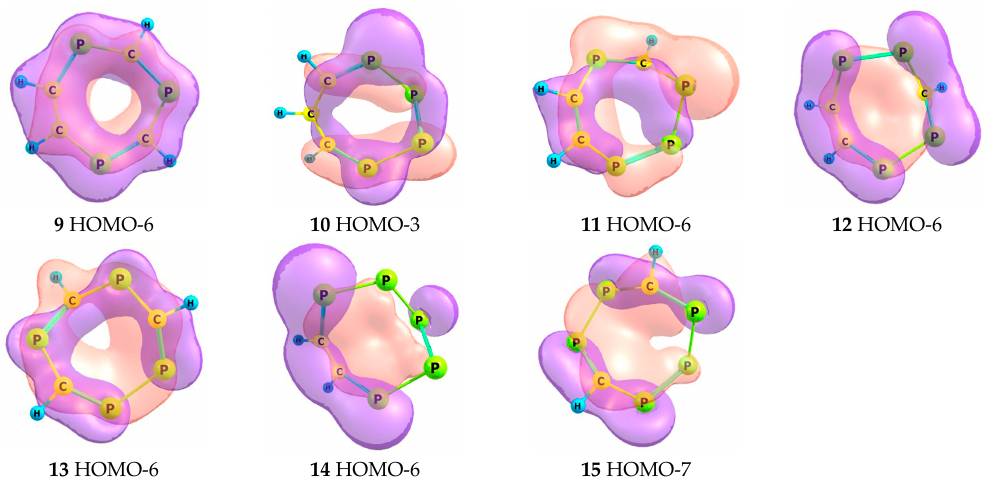
Figure 4. HOMOs of π -symmetry of the tropylium ion and its mono- and poly-phospha analogues at the density functional theory (DFT) (B3LYP/6-31+G(d)) level.